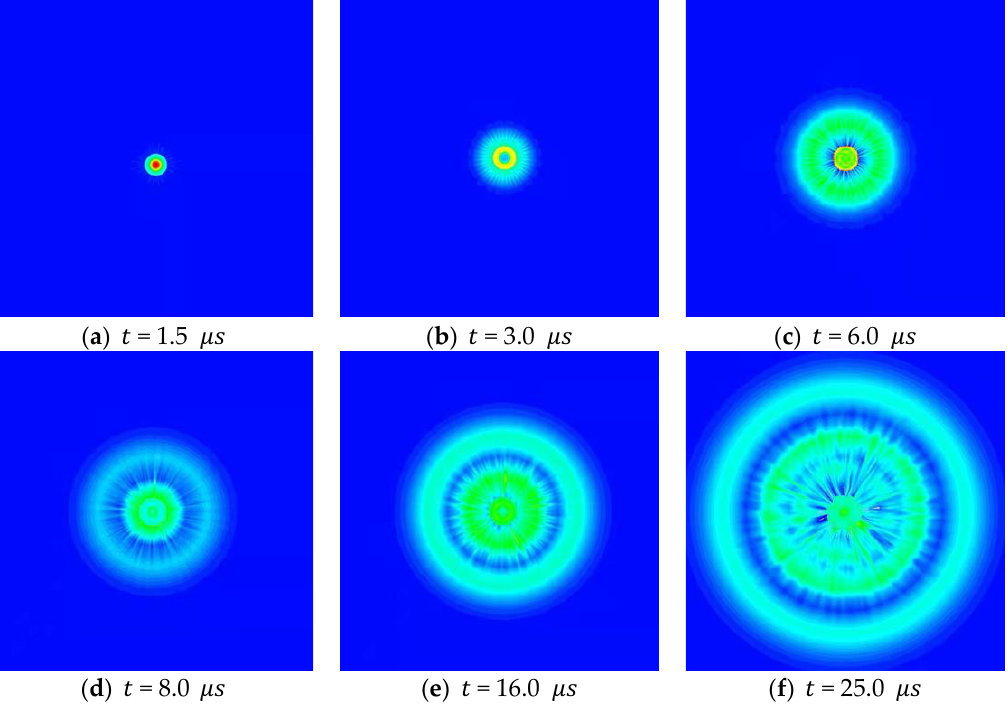
Figure 12. Effect diagram of stress wave propagation after detonation.